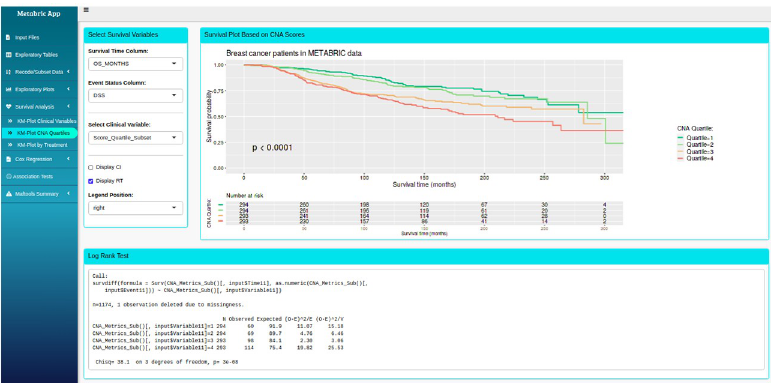
Fig 2. Graphical user interface (GUI) of the R shiny app (manuscript in preparation). Displayed here is the Survival Analysis tab showing the DSS based on CNA Quartiles in luminal cases. Results from the corresponding log-rank test are displayed in the bottom